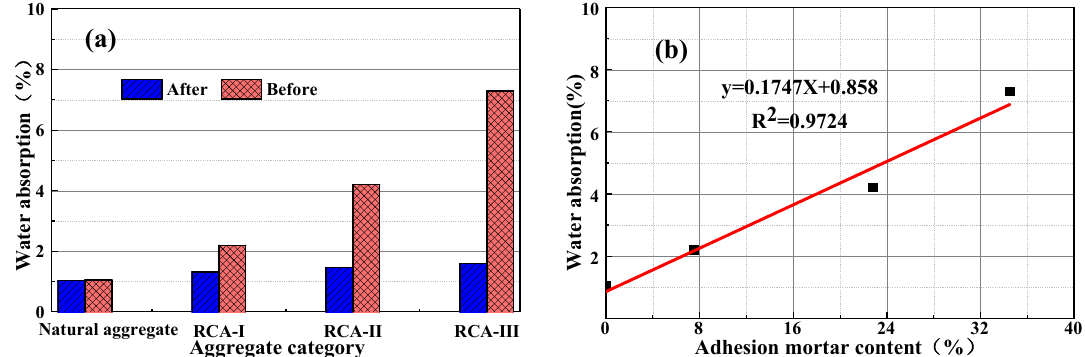
Figure 12. ( a ) Influence of calcination and grinding on the water absorption of recycled aggregate. ( b ) The relationship between the content of attached mortar and water absorption.